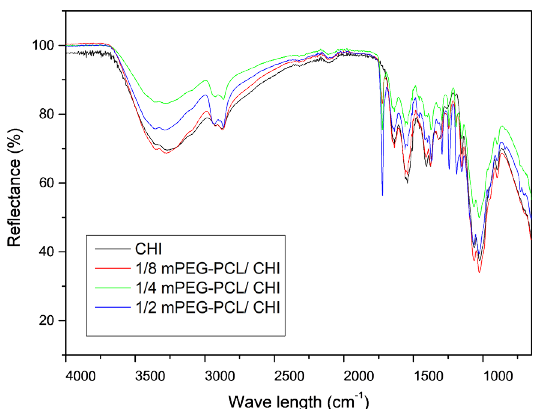
Figure 3. Infrared spectra of membranes: (black) CHI, (red) 1/8 mPEG-PCL/CHI, (green) 1/4 mPEG-PCL/CHI, and (blue) 1/2 mPEG-PCL/CHI.